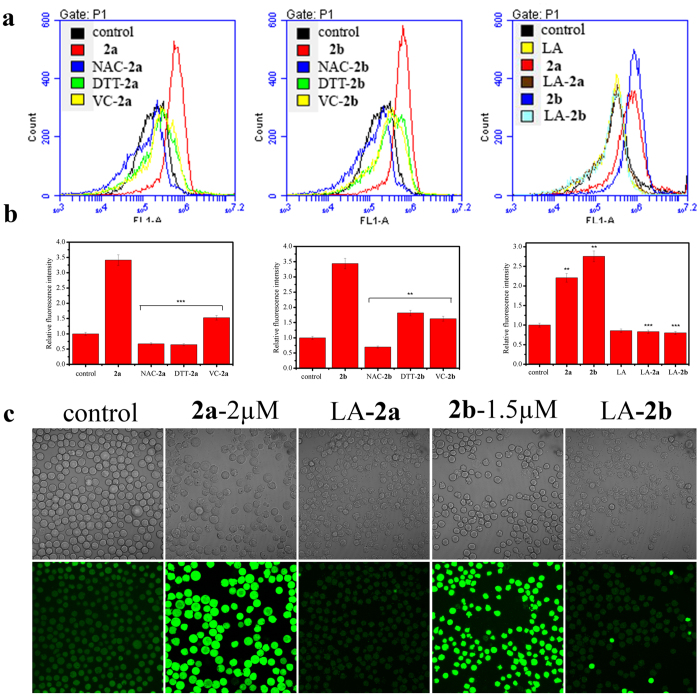
Production and elimination of ROS in HL-60 cells measured by DCFH-DA.(a) The levels of intracellular ROS in the presence of antioxidants and compound 2a or 2b. HL-60 cells were pre-incubated with 2 mM NAC or 1 mM DTT or 1 mM VC or 0.075 mM LA for 4 h followed by the addition of 2 μM 2a or 1.5 μM 2b for another 24 h and the fluorescence data were obtained by flow cytometry. (b) The corresponding quantification data are shown in the way of column figure and expressed as the mean ± SD of three independent samples. **P < 0.01 and ***P < 0.001 vs the control group. (c) The images about the accumulation and elimination of ROS in cells. HL-60 cells were treated with 0.075 mM LA in advance for 4 h before incubated with 2 μM 2a or 1.5 μM 2b for another 24 h. Then 1 mL FBS-free medium with 10 μM DCFH-DA was added into each sample for 30 min at 37 °C. Phase contrast (top) and fluorescence (bottom) images were acquired by fluorescence microscopy.